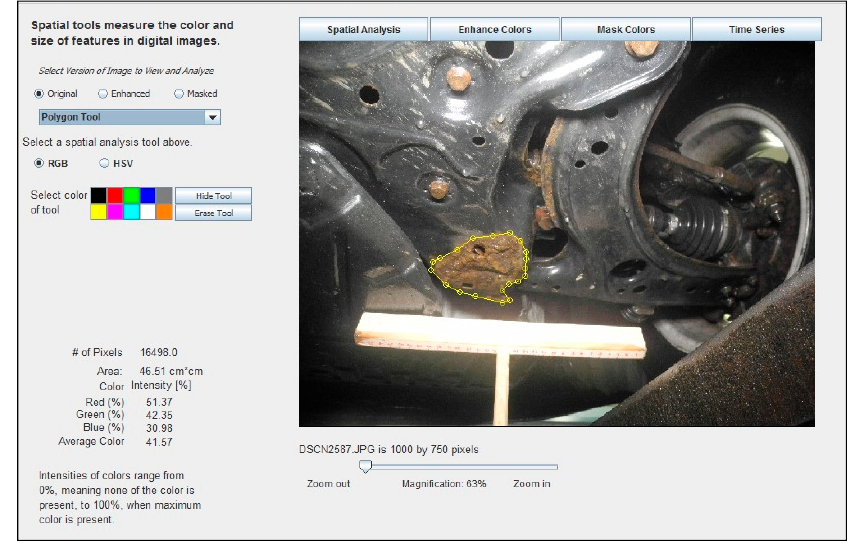
Figure 4. Example of how the ADI software was used to identify, manually delineate, and analyze the corroded area, measuring 46.51 cm 2 , in a digital image of a 2001 Volkswagen Jetta crossmember, measured with the help of a 30 cm long T-scale.